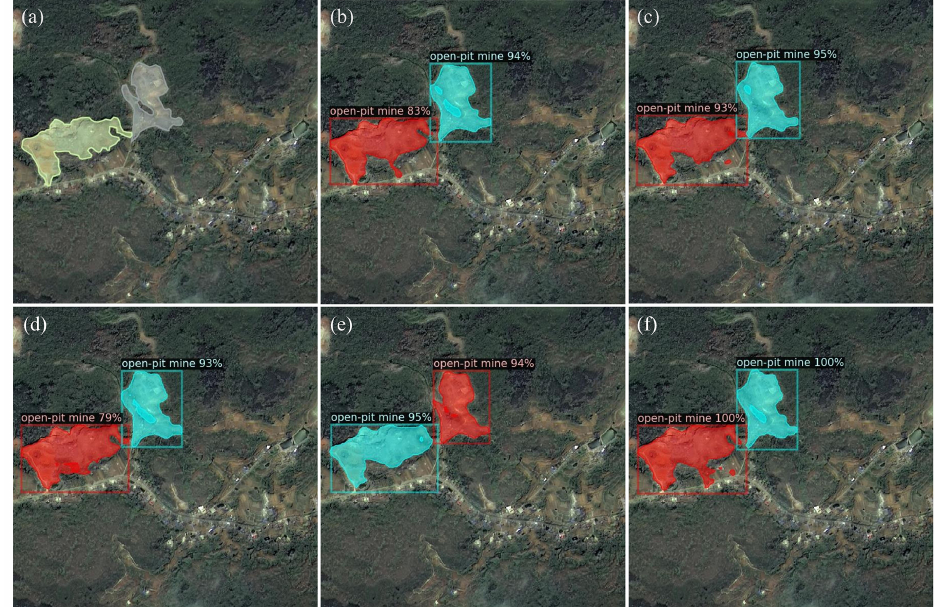
Figure 7. Model inference probabilities and shapes on Gaofen satellite true-color image. ( a ) Ground truth of limestone mines. ( b ) Inference result by BlendMask model; ( c ) inference result by BlendMask- VoV model; ( d ) inference result by CondInst model; ( e ) inference result by CondInst-VoV model; ( f ) inference result by the Mask R-CNN